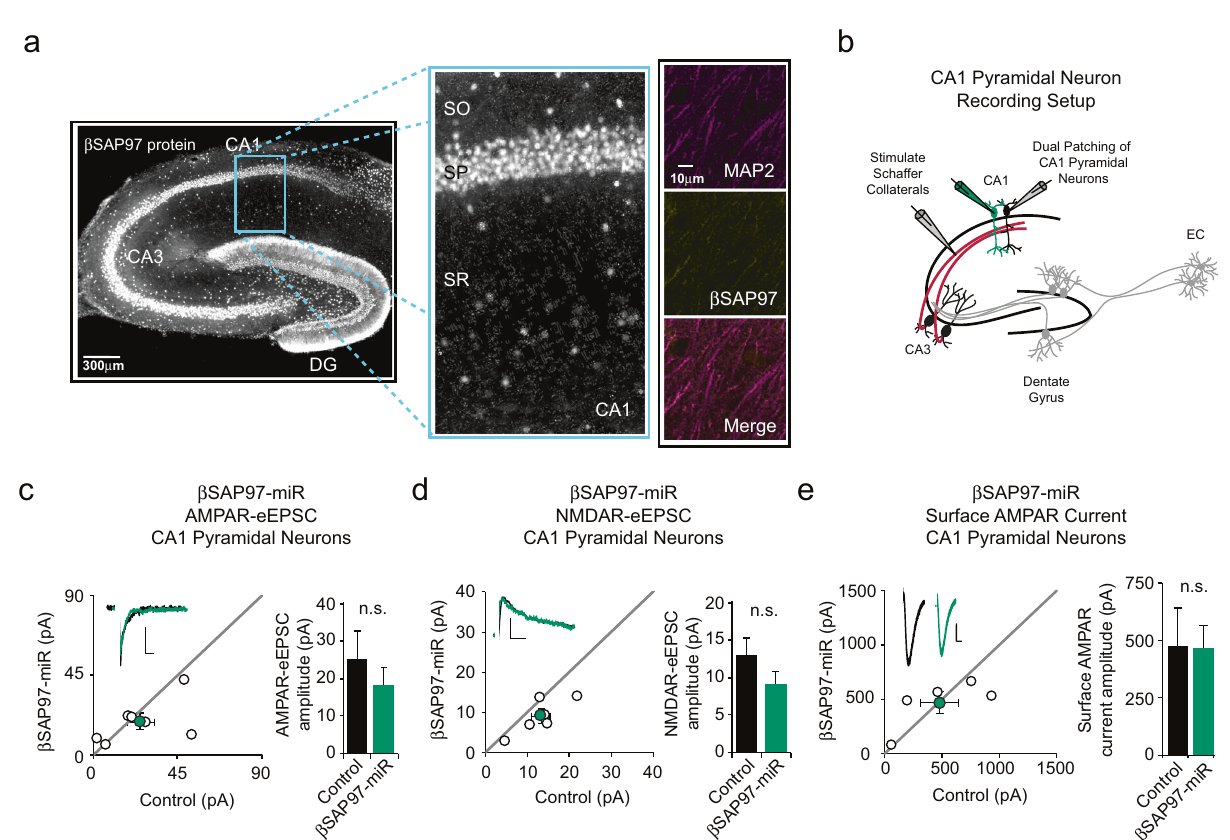
Fig. 2 β SAP97 knockdown has no effect on glutamatergic neurotransmission in CA1 pyramidal neurons. a (Left) Representative immunolabeling of β SAP97 in a rat entorhino-hippocampal slice. Blue box shows enlarged CA1 region. SO, stratum oriens; SP, stratum pyramidale; SR, stratum radiatum. (Right) Co-immunolabeling of MAP2 and β SAP97 in dendrites of CA1 neurons. b Schematic representation of electrophysiological recording setup for CA1 pyramidal neurons. For panels ( c ) and ( d ), open circles are single pairs of control and transfected neurons, fi lled circles represent the mean amplitudes (±SEM), insets show representative current traces from control (black) and transfected (green) neurons with stimulation artifacts removed. Scale bars: 20 ms for AMPA, 50 ms for NMDA, 20 pA. Bar graphs show the average AMPAR-eEPSC and NMDAR-eEPSC amplitudes (±SEM) of CA1 pyramidal neurons expressing the β SAP97-miR (green) and control cell average eEPSC amplitudes (black). β SAP97-miR expression has no detectable effects on either AMPAR-eEPSC ( n = 7 pairs, p = 0.29, paired T test, n.s., not signi fi cant) ( c ) or NMDAR-eEPSC amplitudes ( n = 6 pairs, p = 0.29, paired T test, n.s., not signi fi cant) ( d ) in CA1 pyramidal neurons. e β SAP97-miR does not change surface AMPAR current amplitude in CA1 pyramidal neurons. (Left) Open circles in the scatter plot represent single pairs of control and transfected neurons, fi lled circles represent the mean amplitudes (±SEM), insets show representative surface AMPAR current traces from control (black) and transfected (green) neurons. Scale bars: 5 s, 200pA. (Right) Bar graph shows average surface AMPAR current amplitudes (±SEM) of control (black) and β SAP97-miR expressing (green) CA1 pyramidal neurons ( n = 5 pairs, p = 0.92, paired T test). n.s., not signi fi cant. All statistical tests performed were two-tailed. Source data are provided in the Source Data fi